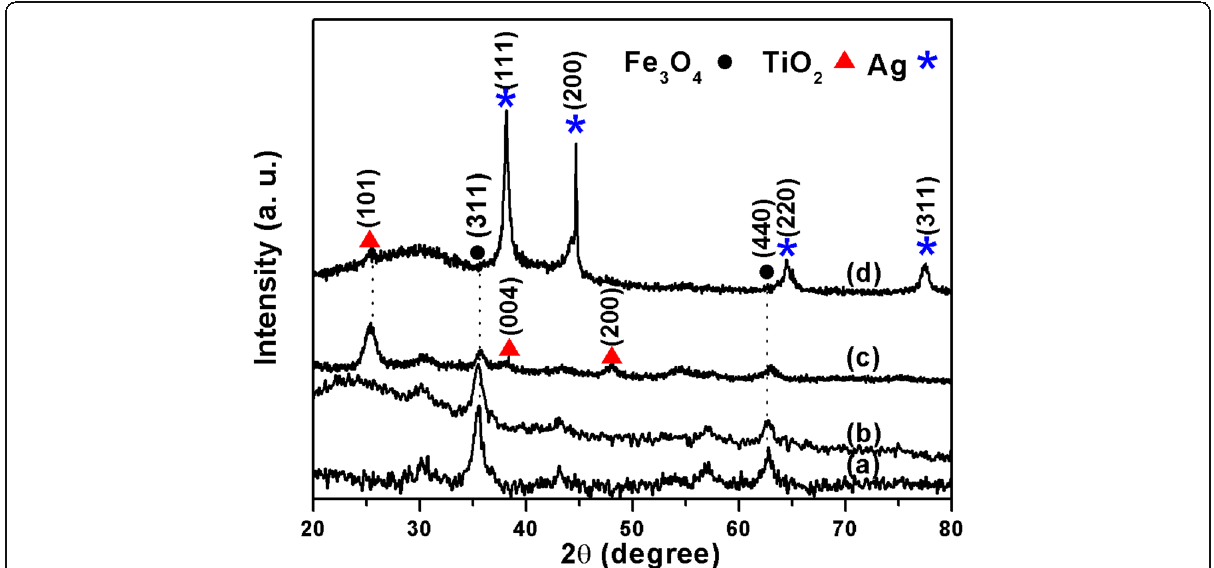
Fig. 2 The XRD patterns of ( a ) Fe 3 O 4 , ( b ) Fe 3 O 4 @SiO 2 , ( c ) Fe 3 O 4 @SiO 2 @TiO 2 , and ( d ) Fe 3 O 4 @SiO 2 @TiO 2 @Ag,